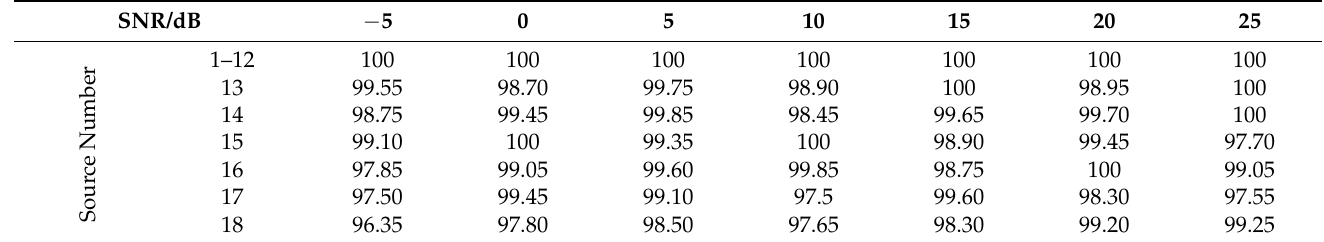
Table 3. Accuracy of sparse array source number estimation at different SNRs.